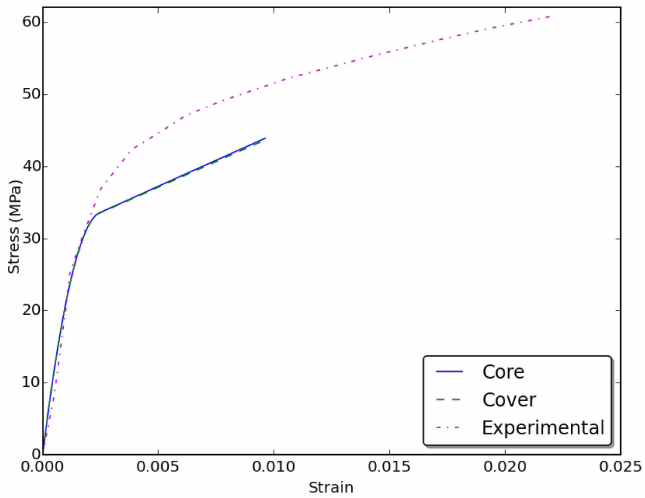
Figure 14. Stress-strain curves for Specimen C30S100N4.